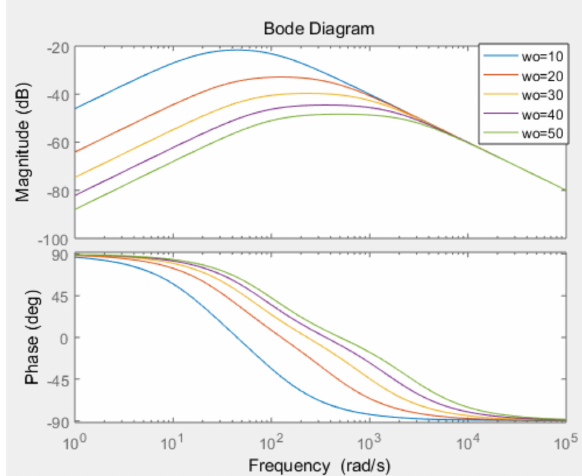
Figure 10. Bode diagram analysis of disturbance of the improved LADRC input